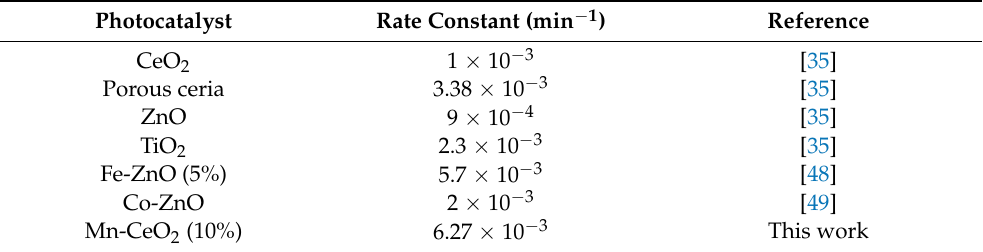
Table 4. A comparison between the rate constant ( k ) of different photocatalysts in the decolorization of methyl green dye under the same reaction conditions.